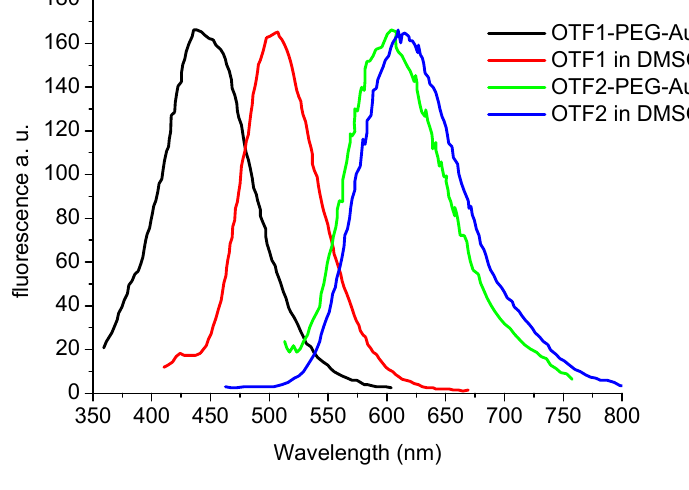
O and OTF2-PEG897-  -Fe O 2 3 2 3